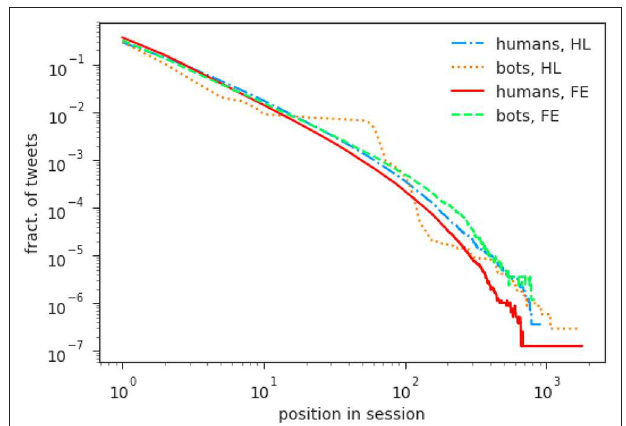
FIGURE 3 | Fraction of tweets appearing in a given position in the course of a session. For both datasets and both categories of accounts, we plot the fraction of tweets posted at a given position in a session. In FE, both distributions (bots and humans) are long-tailed, with the first showing higher values in the tail, thus indicating that bots are likelier than humans to post more tweets in the course of the same session (i.e., without a break of 60 min or more). In HL, the two groups behave rather differently from one another: while humans fall between the two FE groups, bots follow a less regular trend, with a particularly pronounced plateau between position 10 and 50, followed by a steep descent.